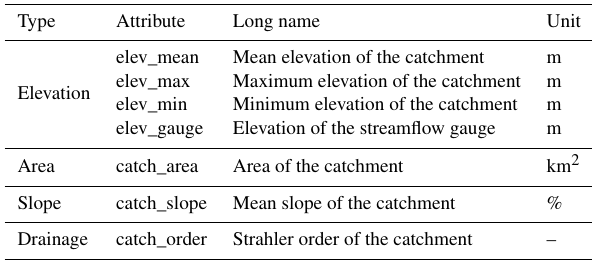
Table 2. Topography attributes of the CABra